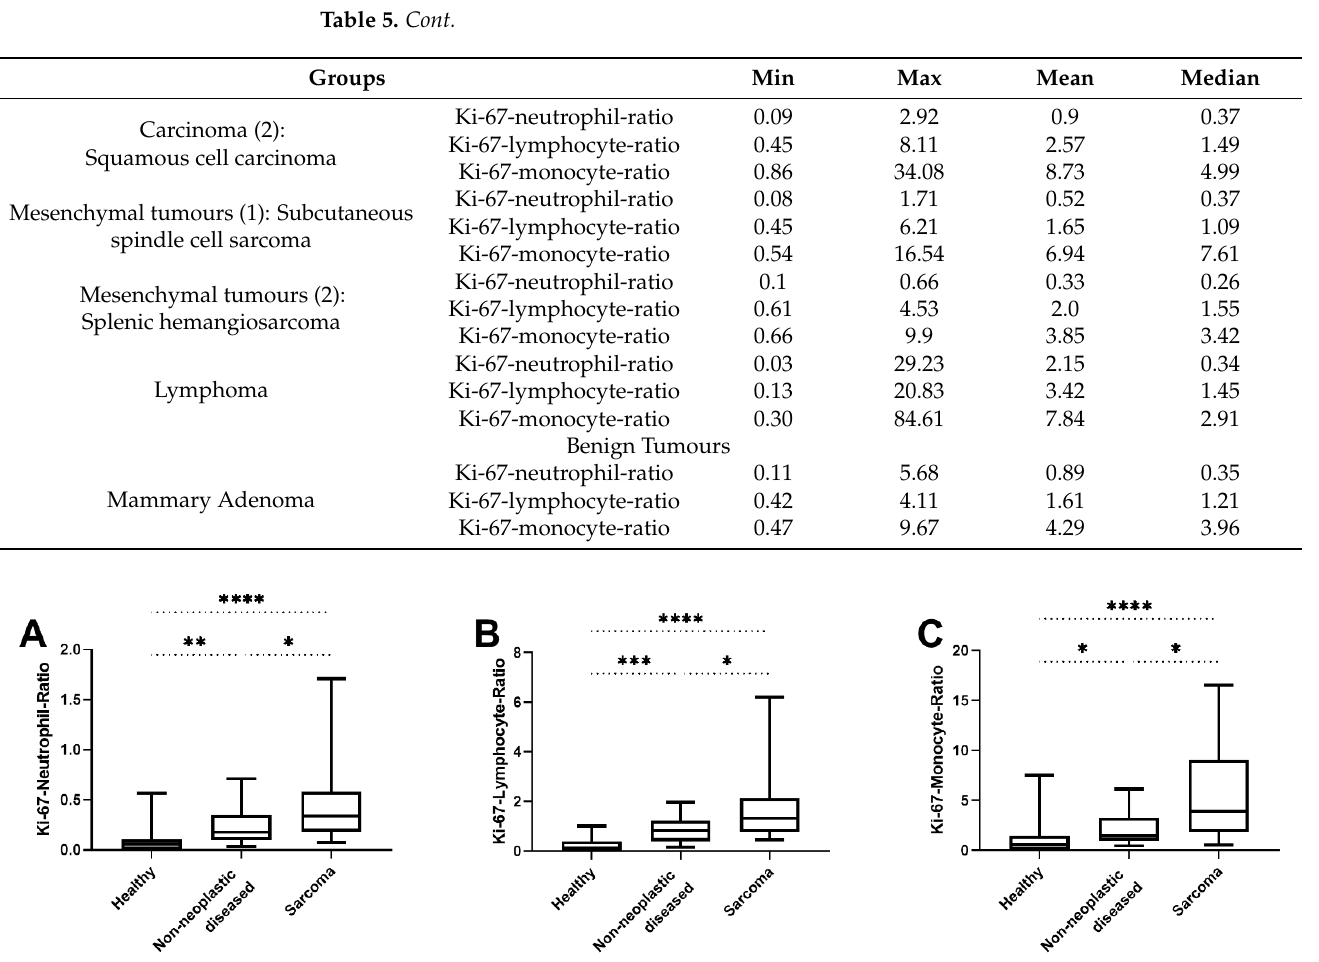
Figure 7. Comparison of ratios between Ki-67 and different inflammatory parameters of healthy dogs, dogs with non-neoplastic diseases, and the sarcoma group. ( A ) The Ki-67–neutrophil ratios of the non-neoplastic diseased group were significantly lower than those of the sarcoma group ( p = 0.04). The healthy dogs also had significantly lower values than both the non-neoplastic diseased and the sarcoma group ( p = 0.001 and p < 0.0001, respectively). ( B ) The Ki-67-lymphcyte-ratios of the non-neoplastic diseased group also were significantly lower than those of the sarcoma group ( p = 0.03). The healthy dogs had significantly lower Ki-67–lymphocyte ratios than both the non-neoplastic diseased and the sarcoma group ( p = 0.0002 and p < 0.0001, respectively). ( C ) The Ki-67–monocyte ratios of the non-neoplastic diseased group were significantly lower than those of the sarcoma group ( p = 0.02). The healthy dogs also had significantly lower values than both the non-neoplastic diseased and the sarcoma group ( p = 0.019 and p < 0.0001, respectively). (*) p < 0.05; (**) p < 0.01; (***) p < 0.001; (****) p <